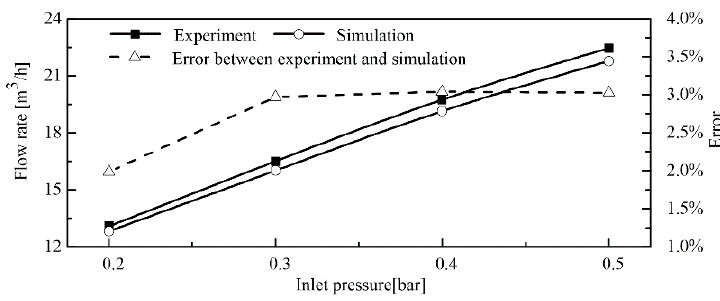
Figure 5. Testing platform of experimental verification.